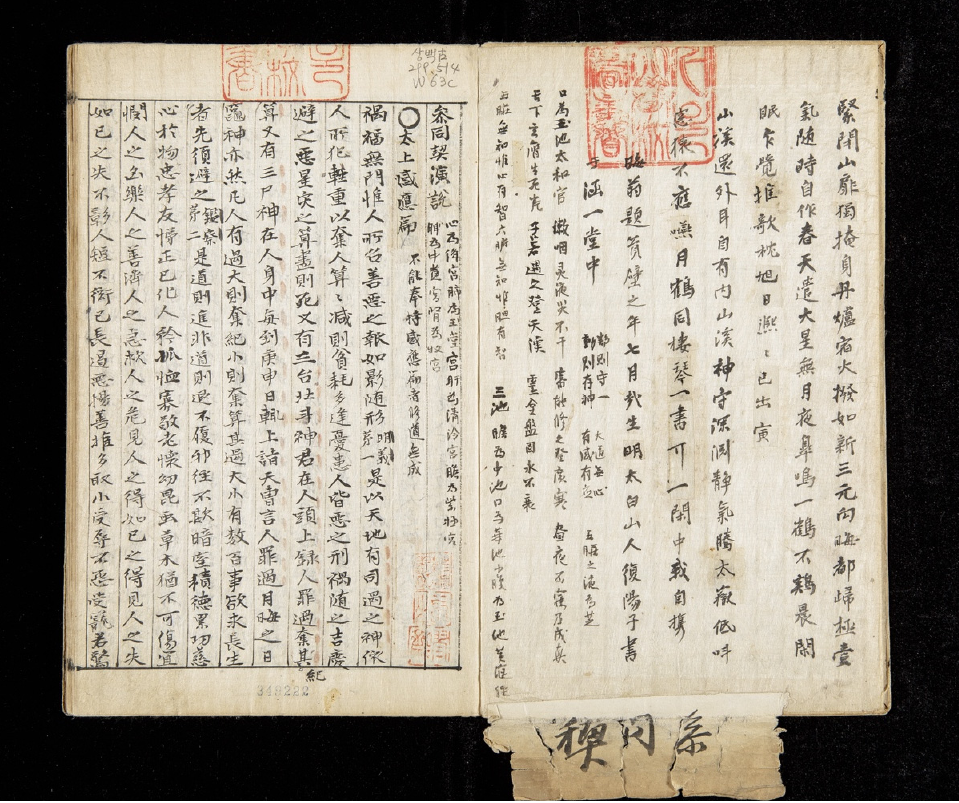
Figure 8. Kang H ŏ n-gyu, Interpretation of the Cantong qi , 1857, Chos ŏ n dynasty (1392–1910). Ink on paper. Kyujanggak Institute of Korean Studies/Seoul National University Central Library ( 想白古 299.514-W63c). Reproduced with permission from Kyujanggak Institute of Korean Studies/Seoul National University Central Library.